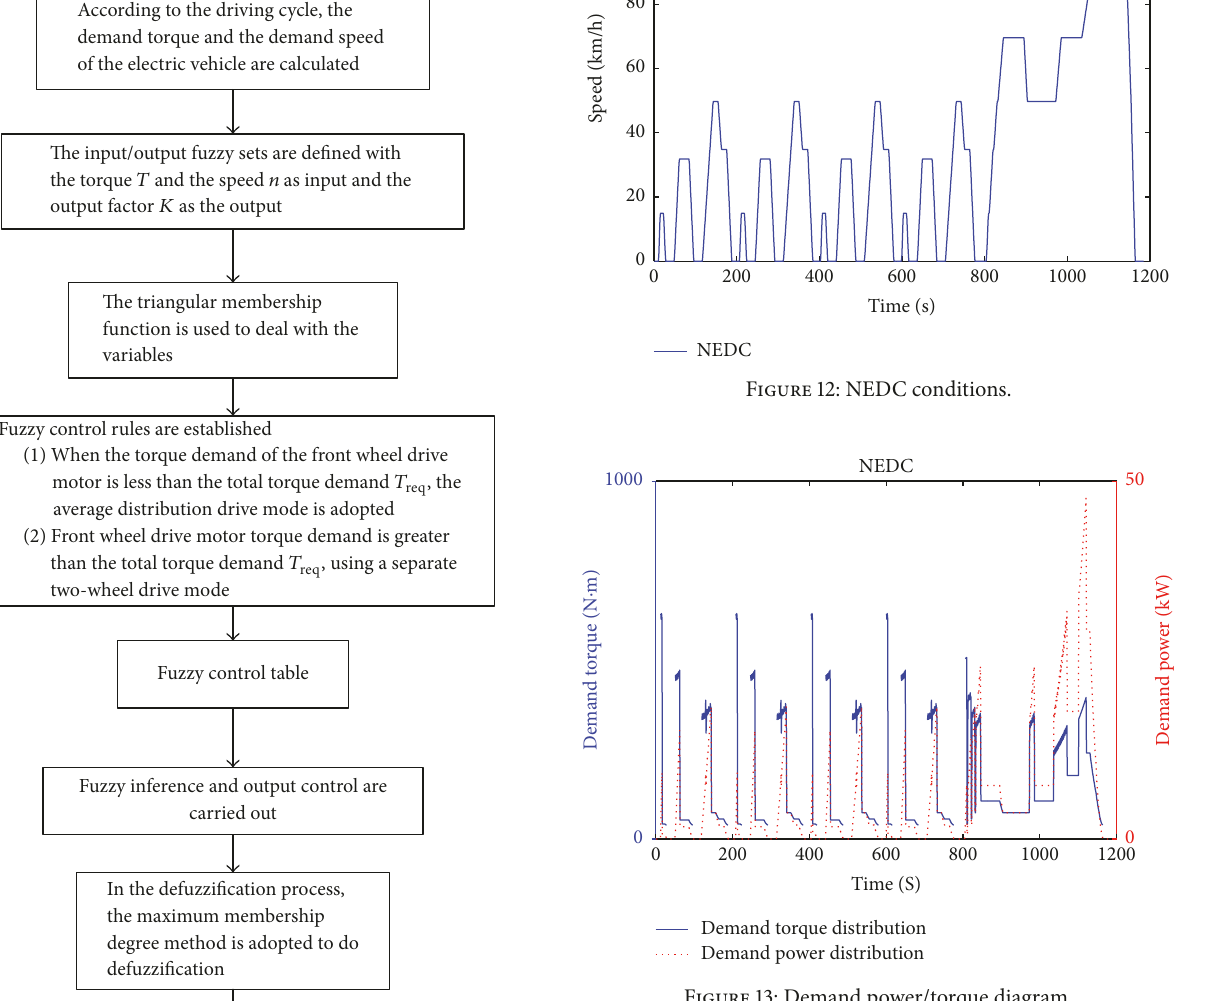
Figure 13: Demand power/torque diagram.